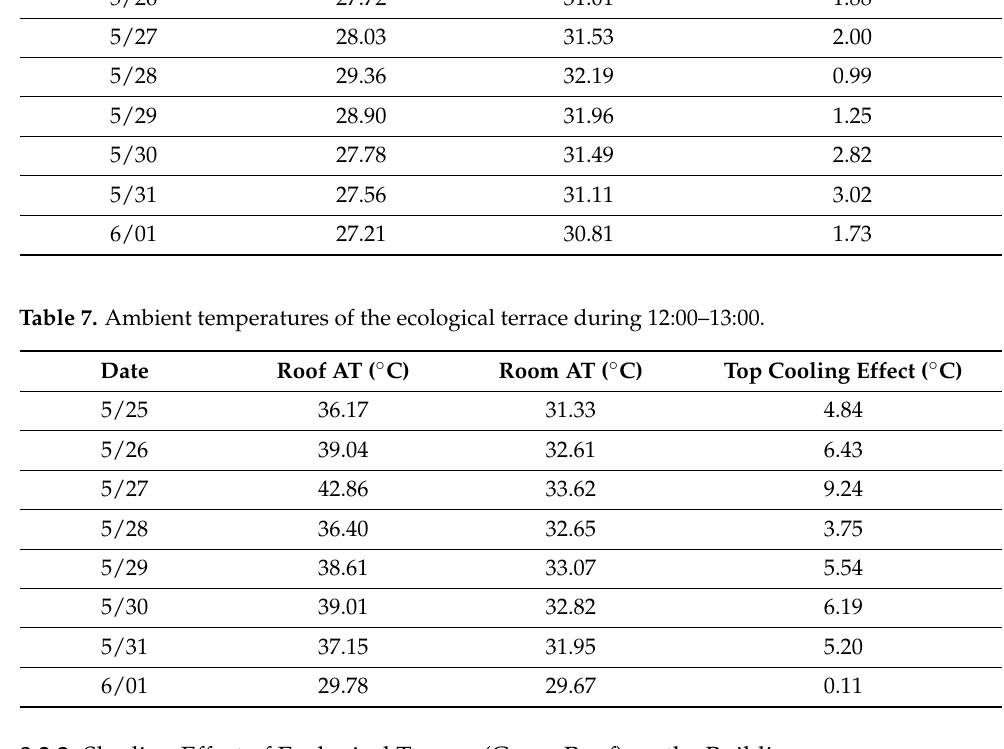
Figure 8. Environmental effects of the ecological terrace during ( a ) 04:00–05:00 and ( b ) 12:00–13:00.